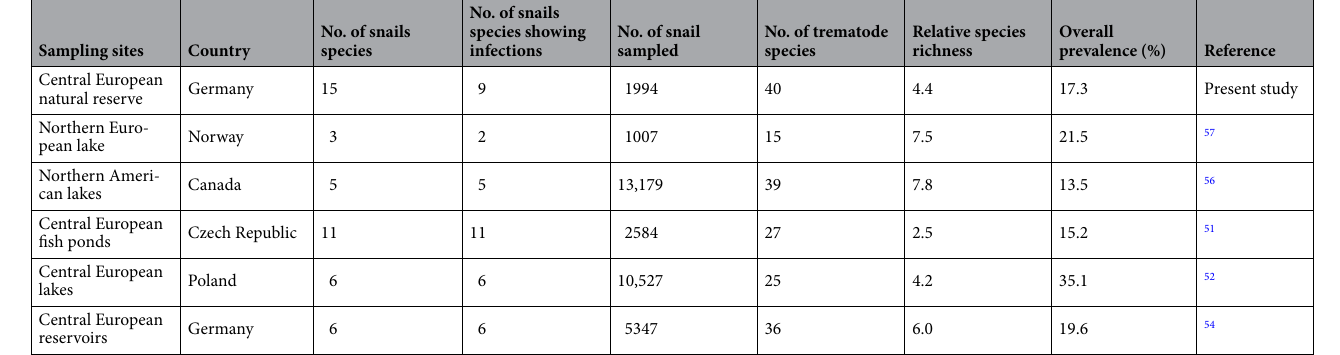
Table 2. Overview of snail host species, trematode species richness and prevalence from comparable well- studied fresh water systems in Europe and North America.